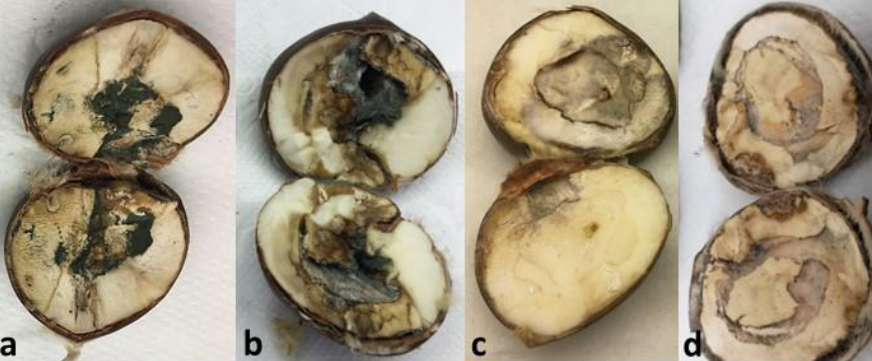
Figure 6. Chestnuts with visible and advanced rot caused by Penicillium brevicompactum ( a ), Ciboria batschiana ( b ), Botrytis cinerea ( c ) and Gnomoniopsis smithogilvyi ( d ). The rot-causing agents were isolated and molecularly identified.